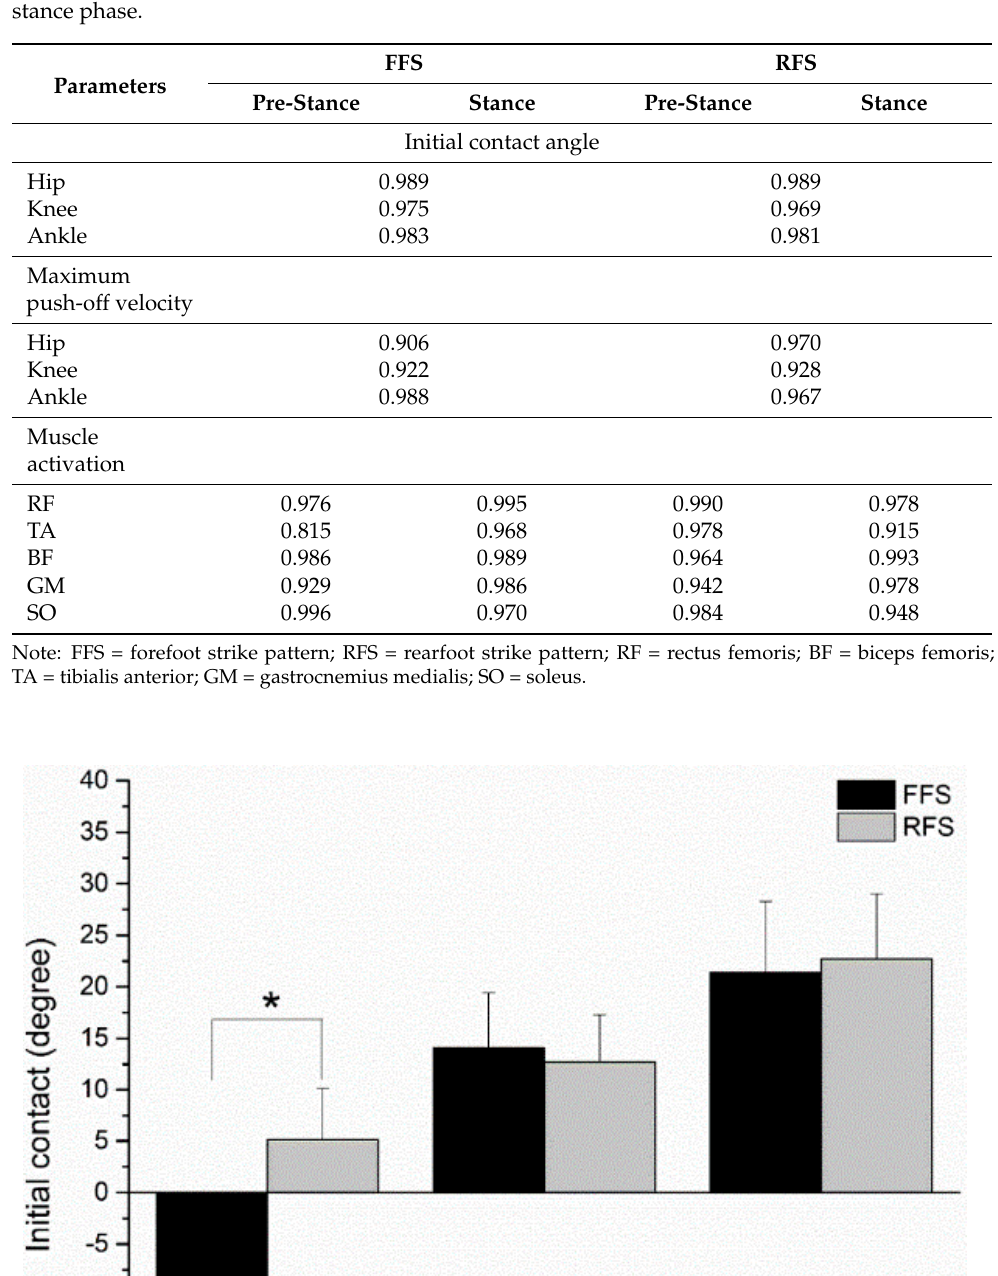
Figure 4. Maximum velocity of push-off of FFS and RFS pattern during stance phase. Note: FFS = forefoot strike pattern; RFS = rearfoot strike pattern. 3.3. EMG Activities The BF muscle demonstrated an activation increase in the pre-stance phase of the FFS pattern compared to the RFS pattern, t (9) = − 3.848, p = 0.004, d = − 1.22, 95% CI [ − 13.53, − 3.51], and the TA muscle increased in the pre-stance phase of RFS pattern compared to in the FFS pattern, t (9) = 3.652, p = 0.005, d =1.15, 95% CI [5.53, 23.55]. During the pre-stance phase, the FFS pattern showed significantly greater MG muscle compared to the RFS pat- tern, t (9) = − 3.917, p = 0.004, d = − 1.24, 95% CI [ − 24.37, − 6.53] (Figure 5). No significant difference in muscle activity was found between the FFS and RFS pattern during the stance phase ( ps > 0.05; Figure 6).